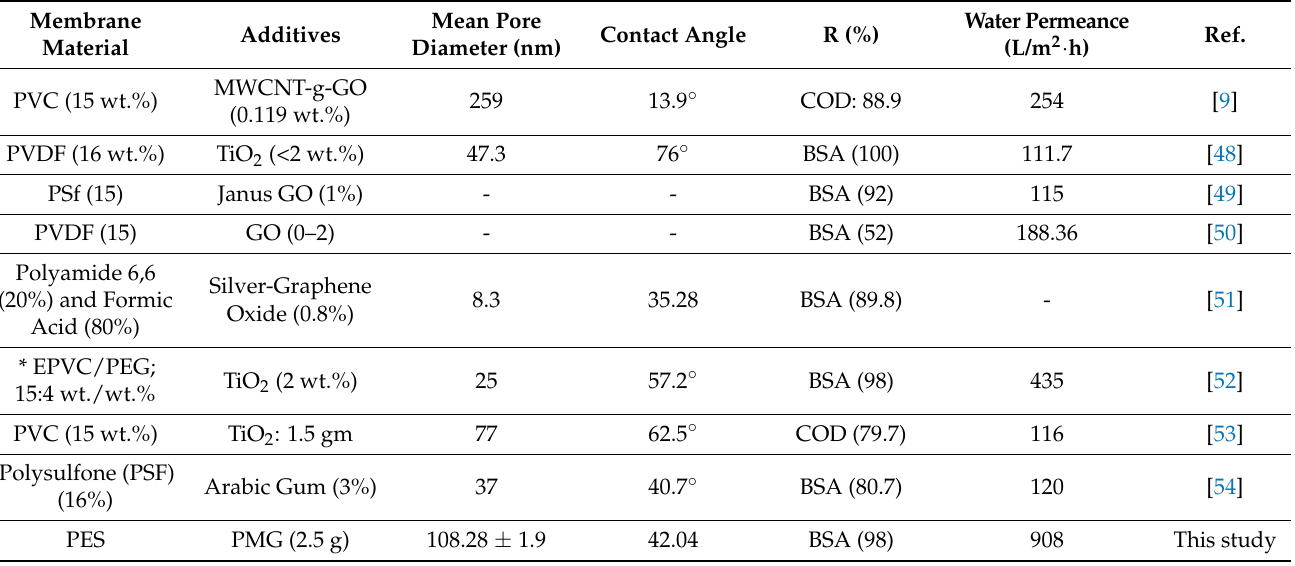
Table 4. Comparison between the membrane performance fabricated in the current work with some membranes presented in the